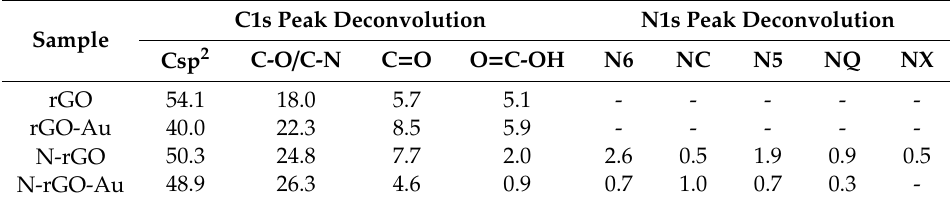
Table 2. Type and amount of oxygen and nitrogen functional groups